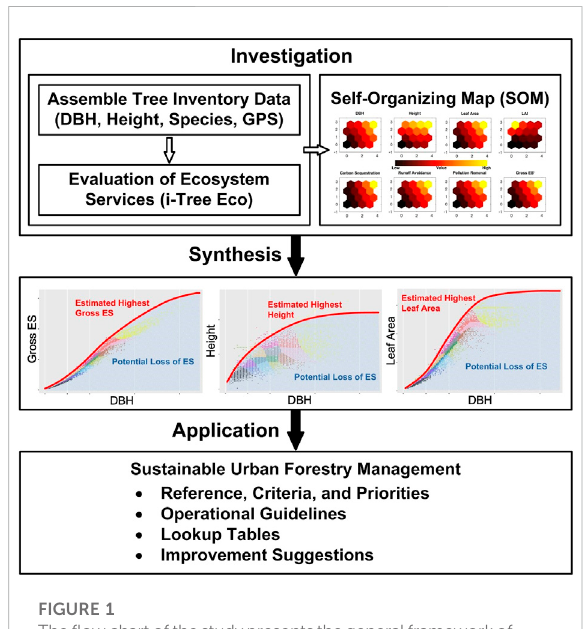
FIGURE 1 The fl owchartofthestudypresentsthegeneralframeworkof the AI-based approach allowing assessment and detection of hidden problems and issues for urban forestry